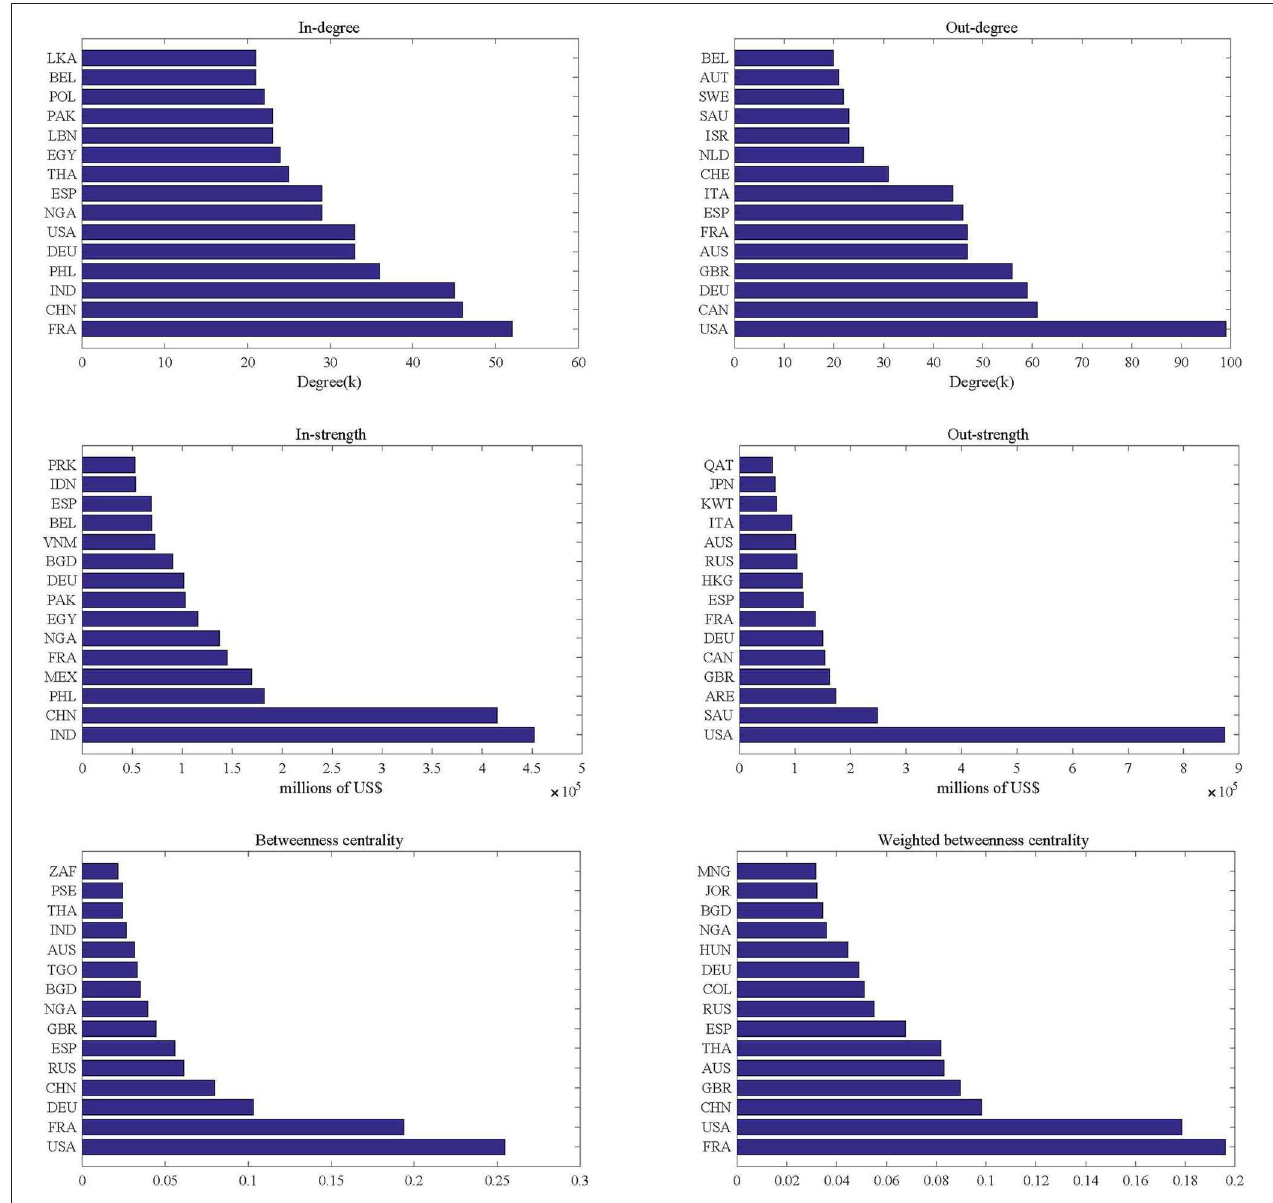
FIGURE 4 | Top 15 important economies based on centrality